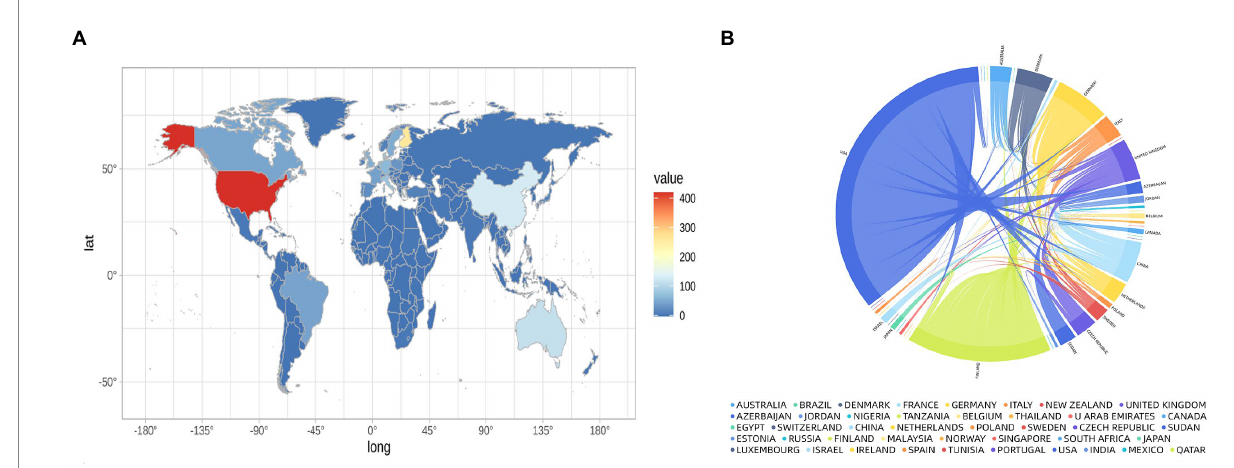
FIGURE 3 Distribution of countries conducting research and international collaborations in the field of gut microbiota and T1D. (A) World map showing the distribution of countries conducting research in this field. (B) International collaboration network of the top 20 countries.